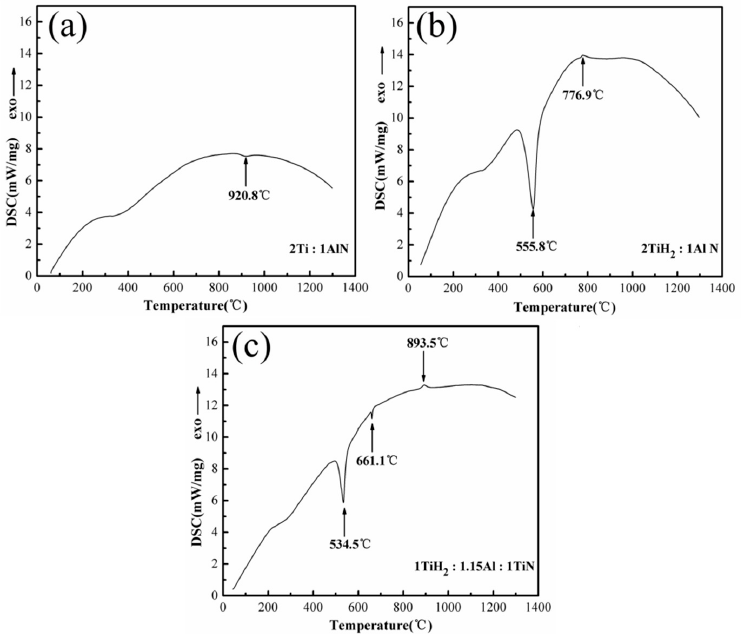
/ 1AlN; ( b ) 2TiH / 1AlN; and ( c ) 1TiH 2